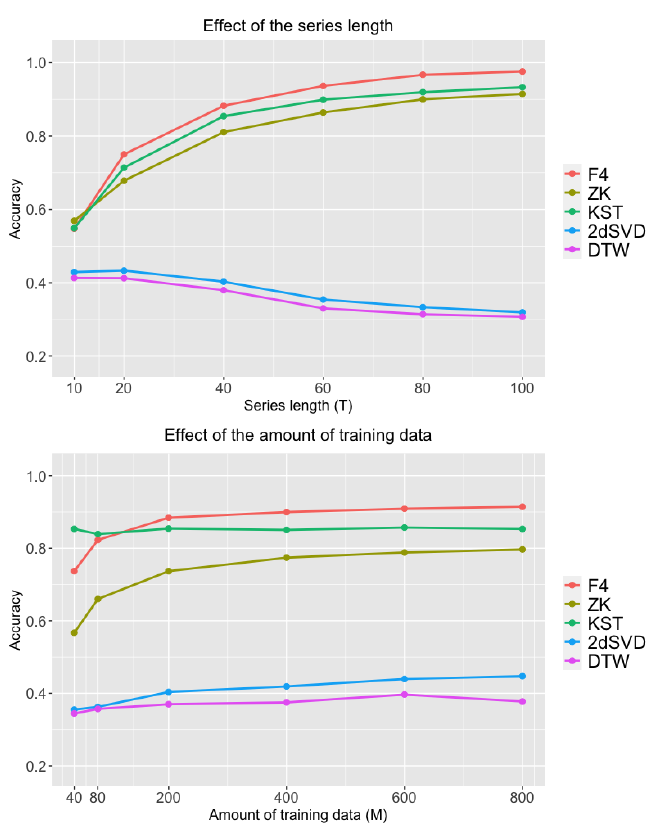
Figure 6. Average accuracies of the five classifiers as a function of the series length (top panel) and the amount of training data (bottom panel). One hundred simulation trials of Scenario 2 were considered for each value of T and M